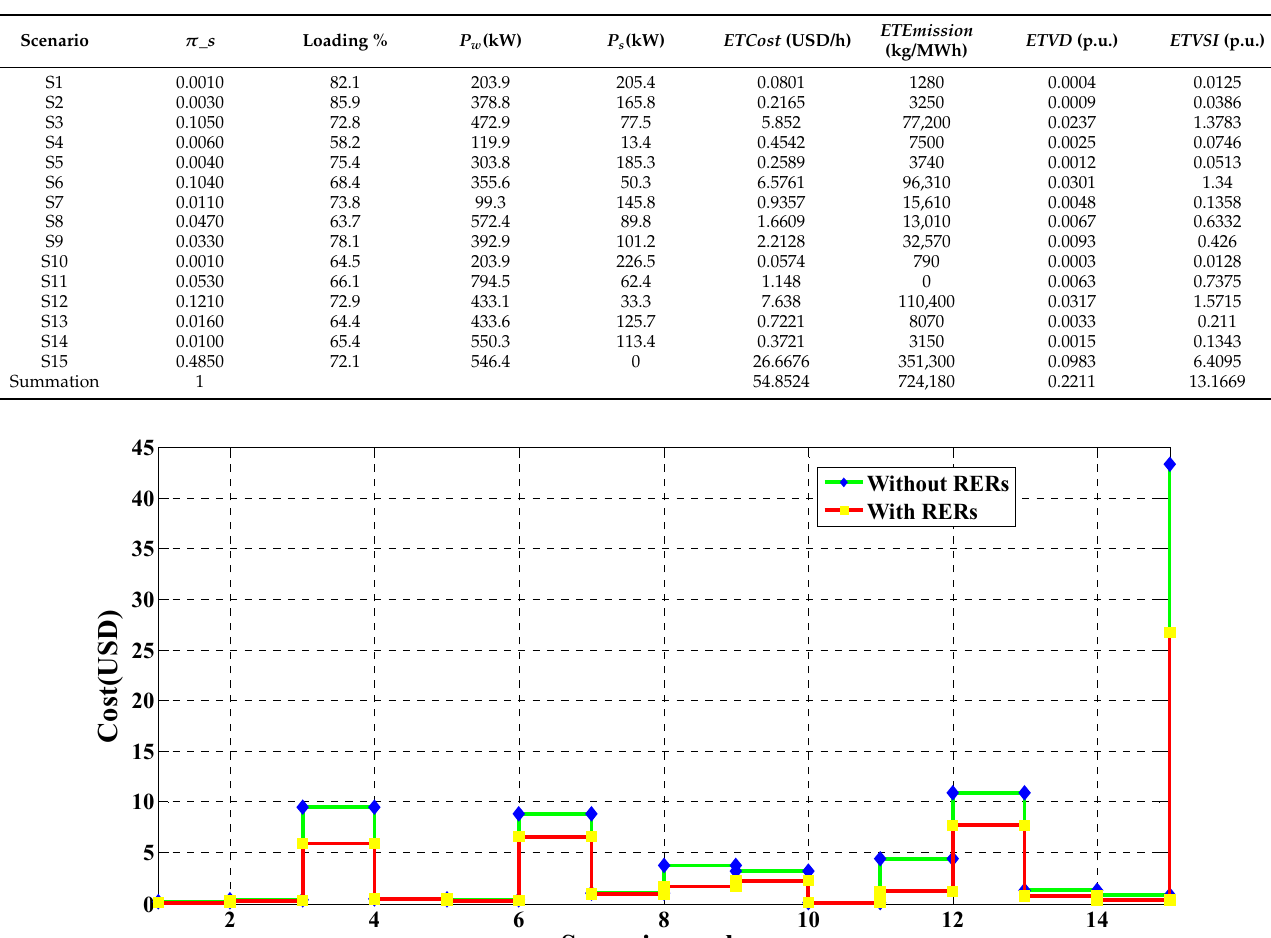
Figure 20. The 15-bus system total costs.